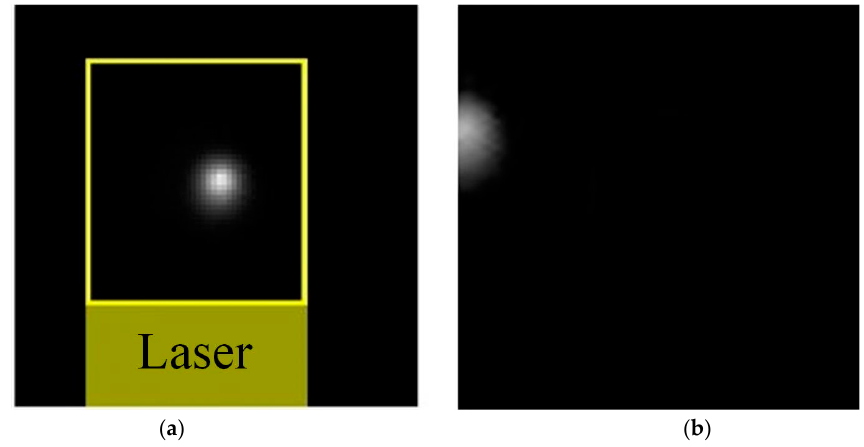
Figure 3. ( a ) Image of regional center that is not the light spot center; ( b ) incomplete laser spot image.